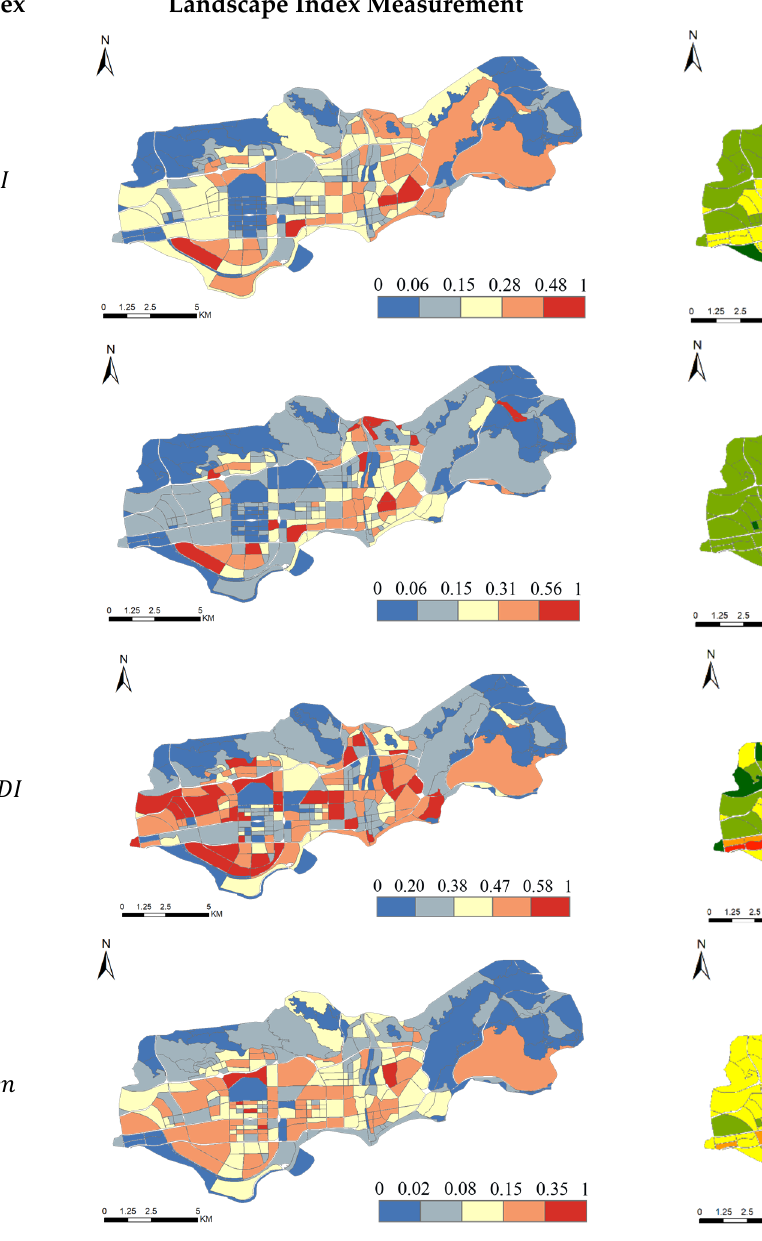
2 concentration